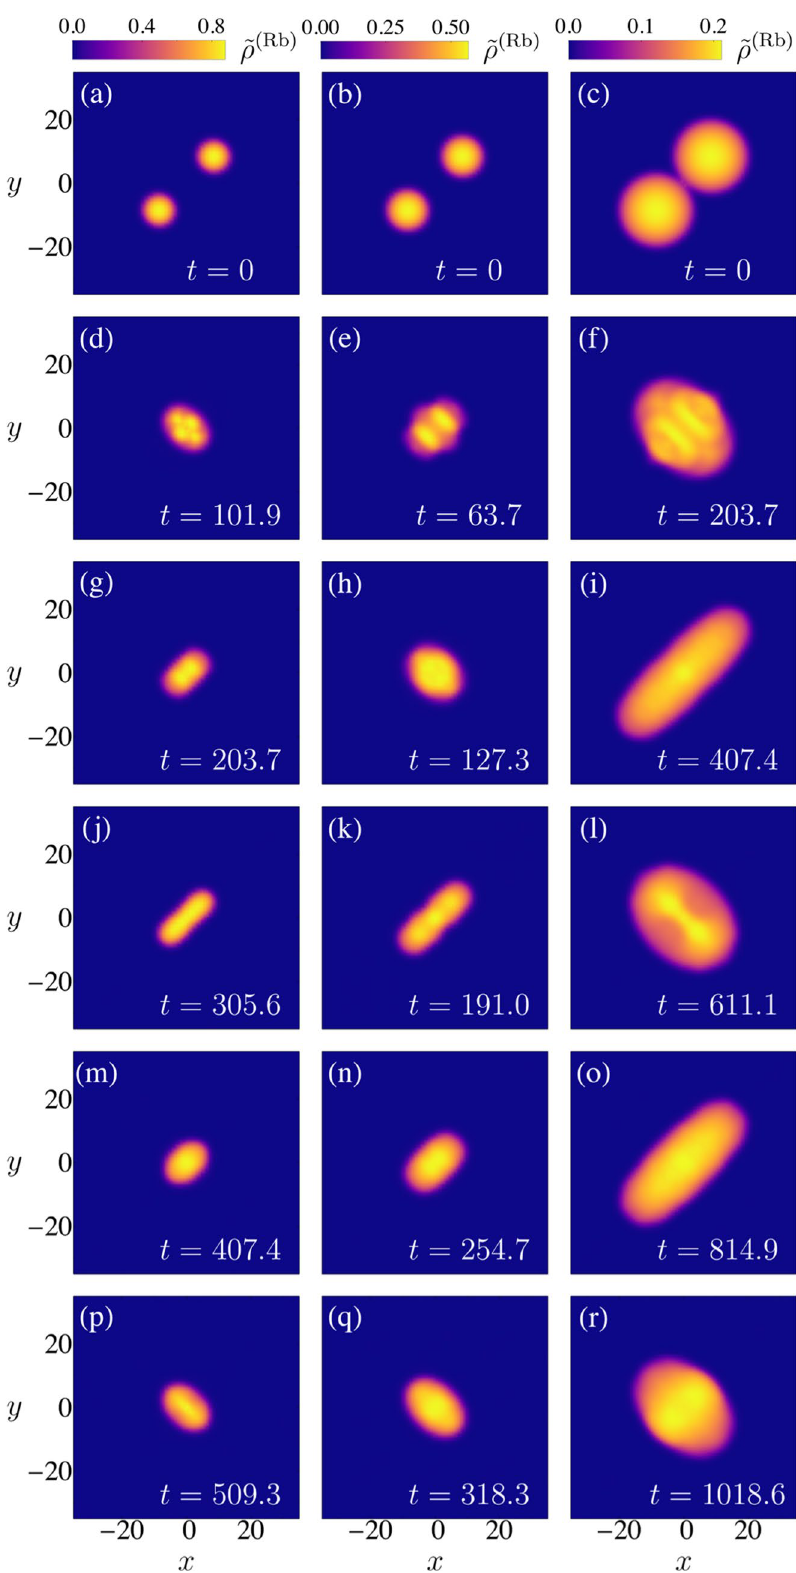
Figure 3. Illustrative examples of frontal collisions of two droplets leading to its coalescence. Identical hetero- nuclear droplets of Rb and K atoms are considered in each column, where the density of Rb atoms integrated dz ρ ( Rb ) ( x , y , z ) is depicted at different evolution times. The initial along the z-direction ˜ ρ ( Rb ) ( x , y ) = translational kinetic energy is varied to guarantee that for N Rb = 5 × 10 5 (first column), N Rb = 1 × 10 6 (second (cid:31) ( A 1 ) 6.2 column) and N Rb = 5 × 10 6 (third column) the Weber number equals We 2 =